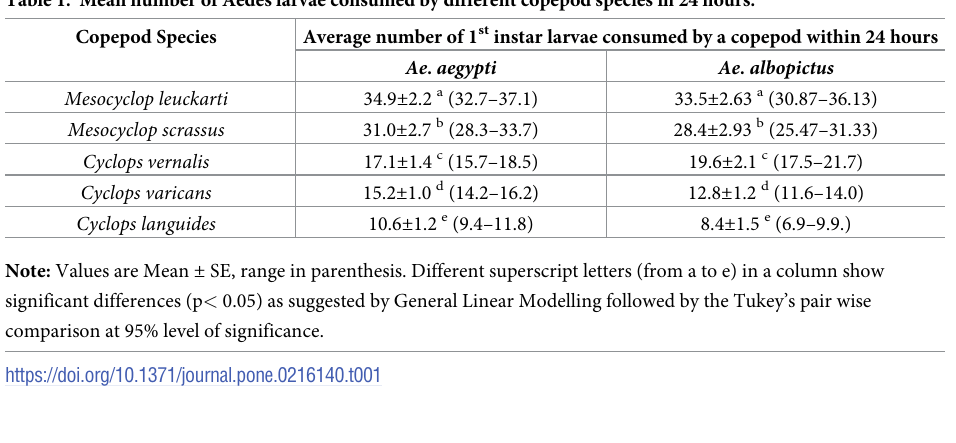
Table 1. Mean number of Aedes larvae consumed by different copepod species in 24 hours. Copepod Species